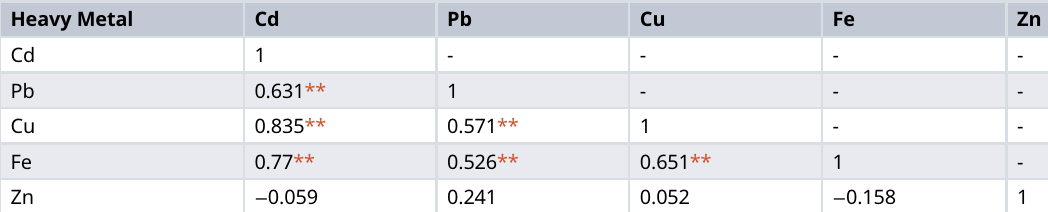
Table 3. Correlation of heavy metal in Caulerpa racemosa Northerly – Westerly monsoon in Bintan Island coastal water.